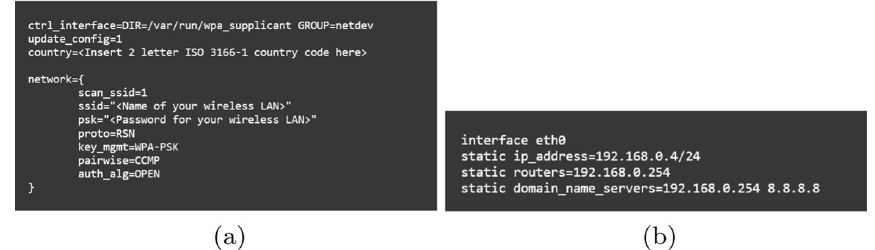
Fig. 2 Example for Network configuration information of Raspberry Pi a Dynamic b